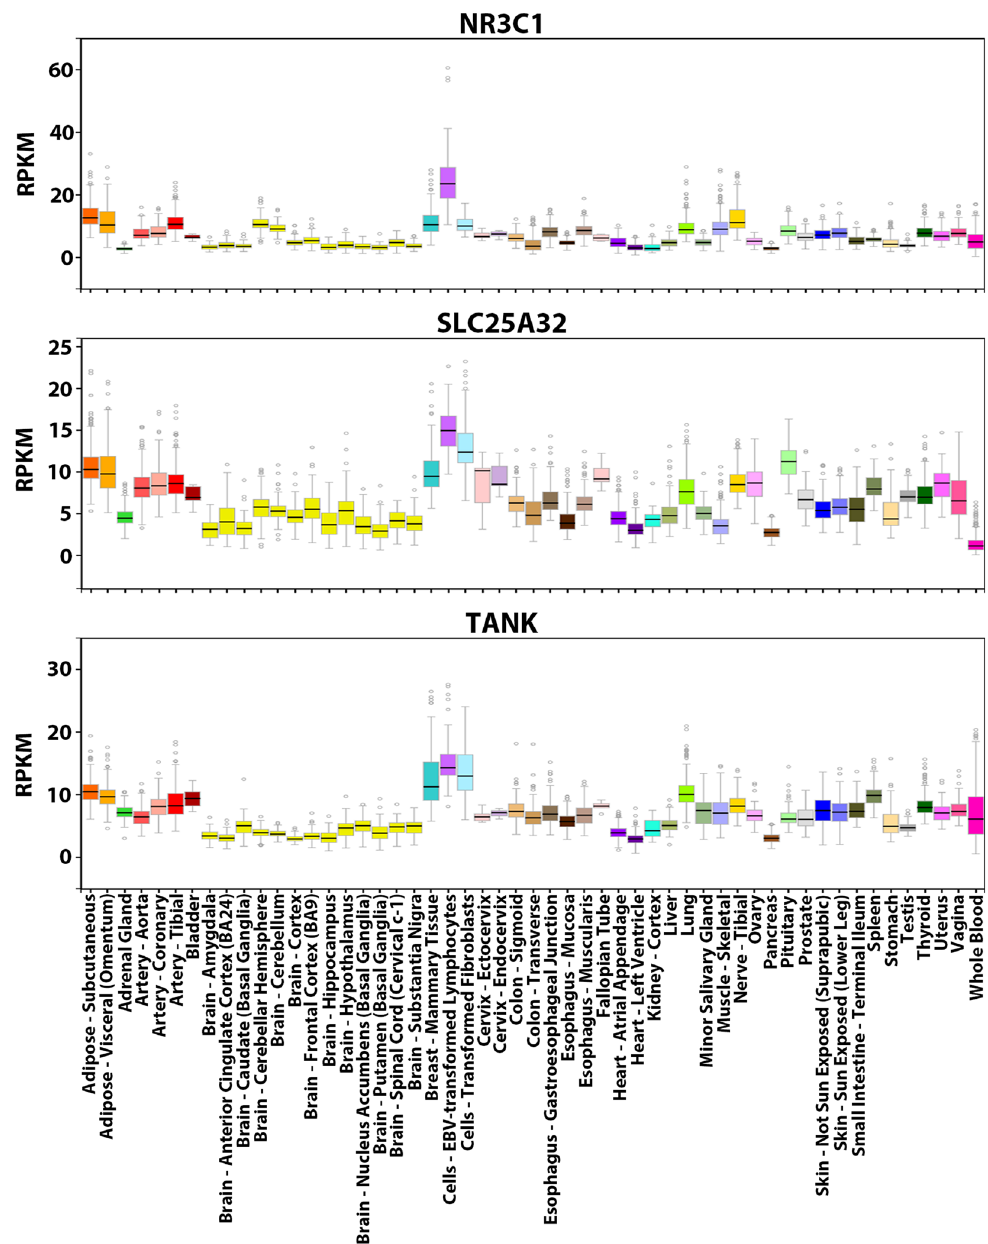
Figure 2. GTEx tissue-wide expression profiles of NR3C1 , SLC25A32 and TANK . Visualization of the expression values (in RPKM) of these genes across 53 tissues from GTEx. For each gene, the colored rectangle belonging to each tissue indicates the valid RPKM of all samples in the tissue, the black horizontal bar in the rectangle indicates the median RPKM, the hollow circles indicate the RPKM of the samples considered as outliers, and the grey vertical bar indicates the sampling error. A comparison of the panels shows that the overall expression patterns of the three genes across the 53 tissues resemble each other (e.g. all three genes exhibit the highest expression levels in lymphocytes and the lowest levels in brain